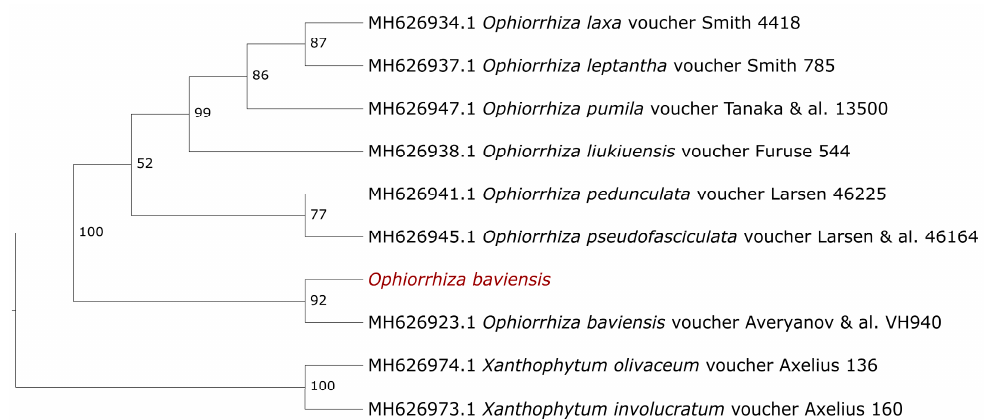
Figure 8. The maximum likelihood phylogenetic trees based on the concatenated sequences between the rps16 genes and the trnL-trnF intergenic spacer. Numbers on the branches indicate bootstrap percentage after 1000 replications in constructing the tree. The species investigated in this study are colored in red.